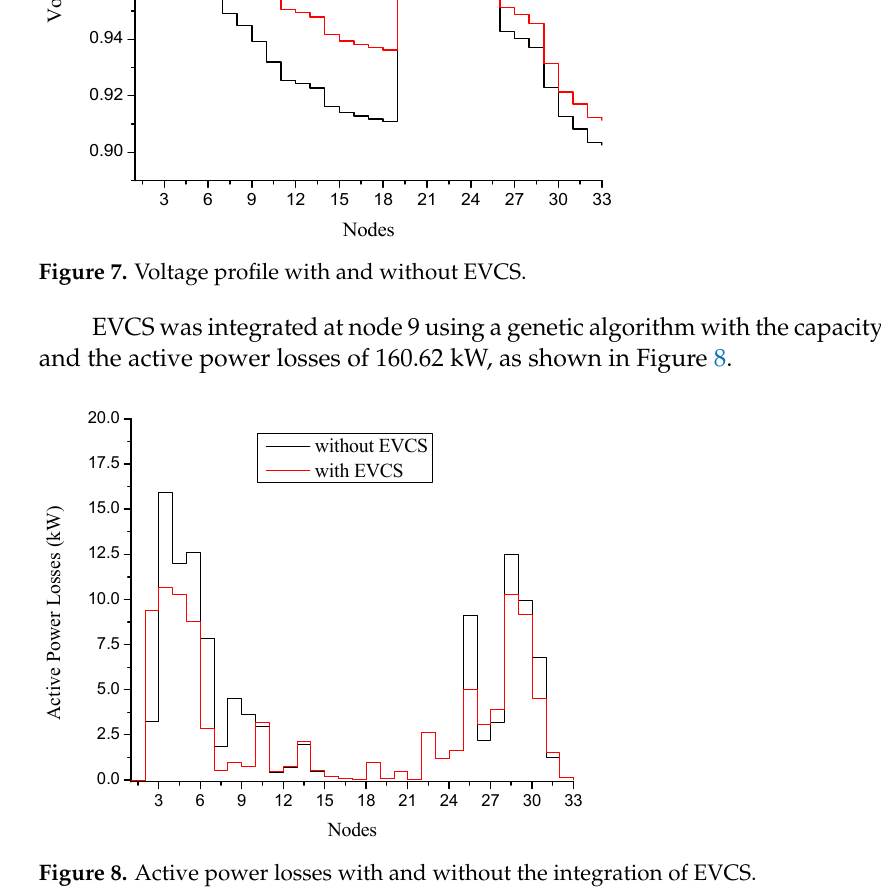
Table 2. Comparison of parameters with and without EVCS. Parameters